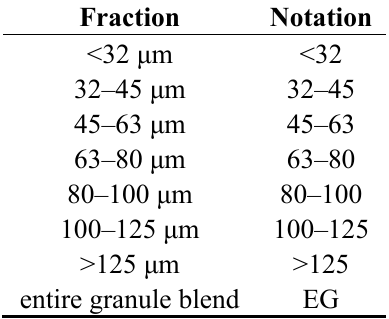
Table 1. Fractions of hydroxyapatite granule